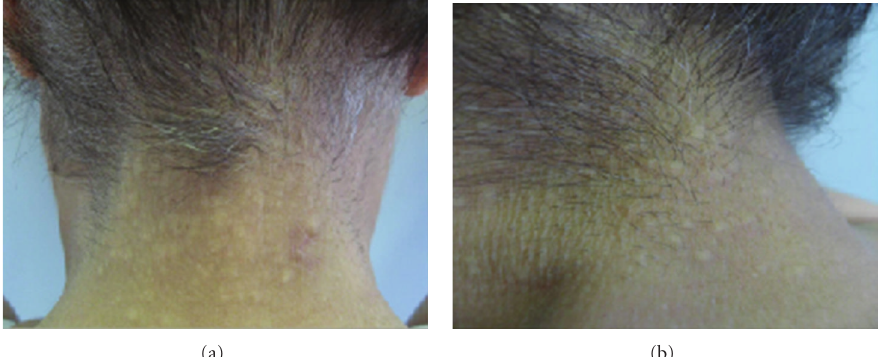
Figure 1: Clinical images of yellowish, symmetrical, and bilateral nonfollicular papules, located on the posterior and lateral region of the neck, respectively.